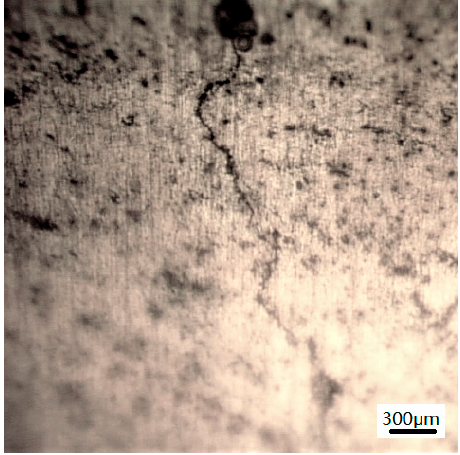
Figure 8. A fine microscopic micro-crack on the surface of test specimen containing an FSW joint. (Duration of exposure = 16 h, applied stress ( σ ) of 79 MPa).